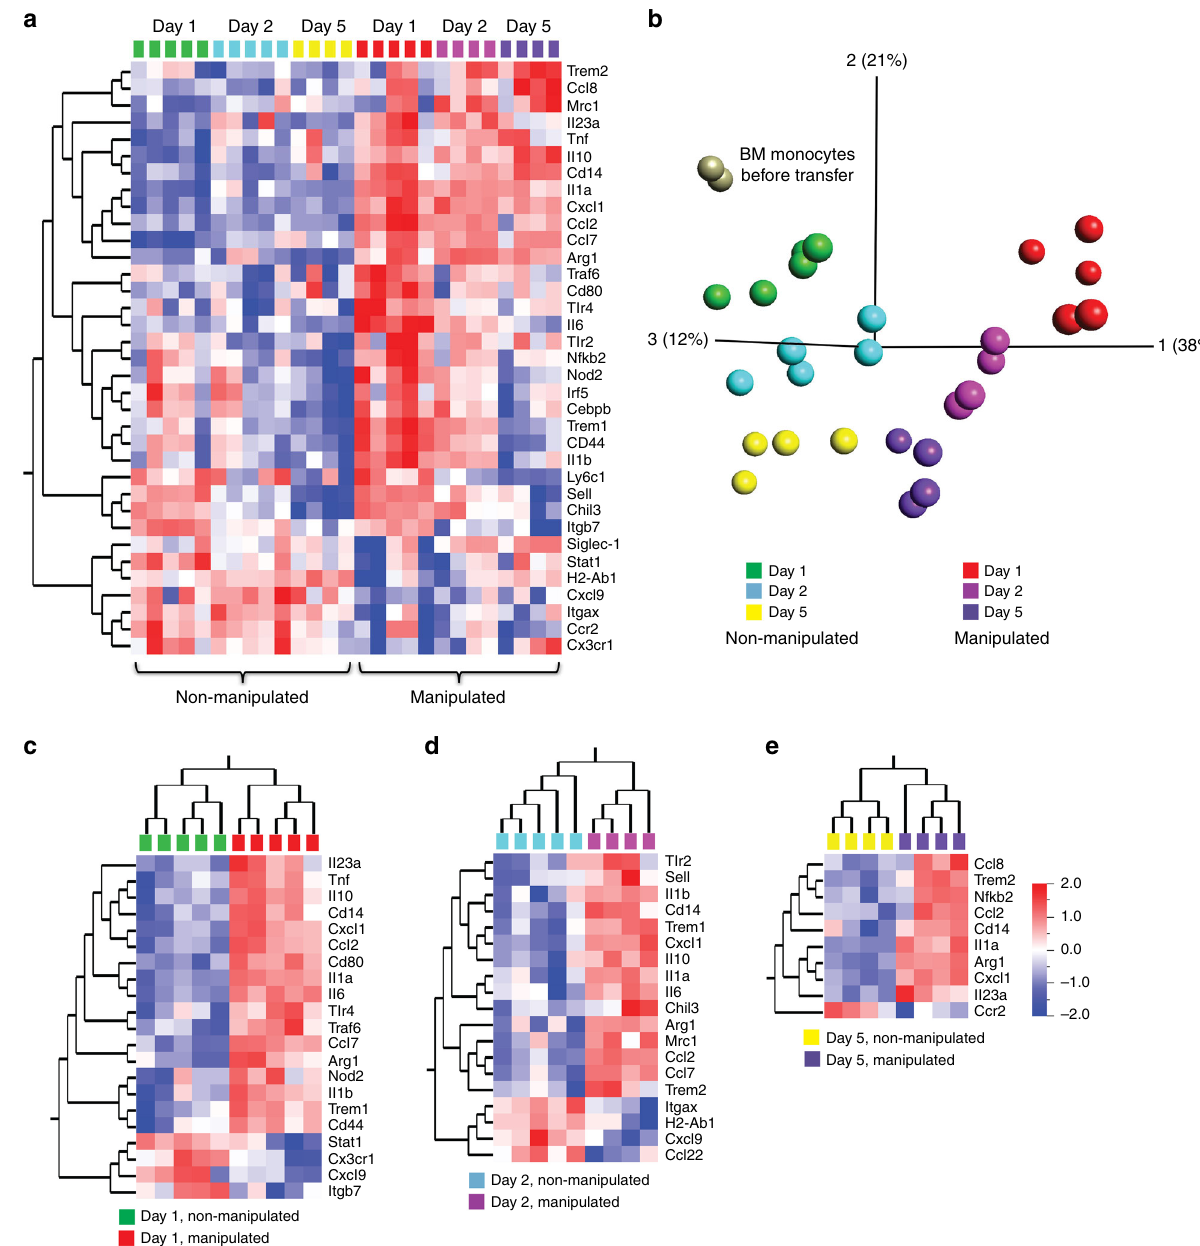
Fig. 5 In fl ammation triggers transcriptomic changes in monocyte immediately upon entry into the small intestine. a Heat map demonstrating gene expression pro fi les of adoptively transferred CD11b + CD11c lo/int CD64 + (MNP CD64 + ) cells recovered small intestinal lamina propria (siLP) of non- manipulated and manipulated recipients at day 1, 2, and 5 after transfer. b Principal component analysis (PCA) representing transcriptomic pro fi les of donor BM monocytes before transfer and adoptively transferred MNP CD64 + cells recovered from siLP of non-manipulated and manipulated recipients at day 1, 2, and 5 post-transfer. c – e Heat map showing hierarchal clustering of gene expression pro fi les of donor MNP CD64 + cells recovered from the siLP at day 1 ( c ), day 2 ( d ), and day 5 ( e ) after transfer comparing non-manipulated and manipulated recipients. Transcriptomic analysis was performed by nanostring nCounter analysis and differentially expressed genes were determined by Qlucore Omics explorer with a statistical signi fi cance p -value of 0.05. Data were pooled from 2 – 3 independent experiments with a total of 2 – 5 mice as indicated in each section of the fi